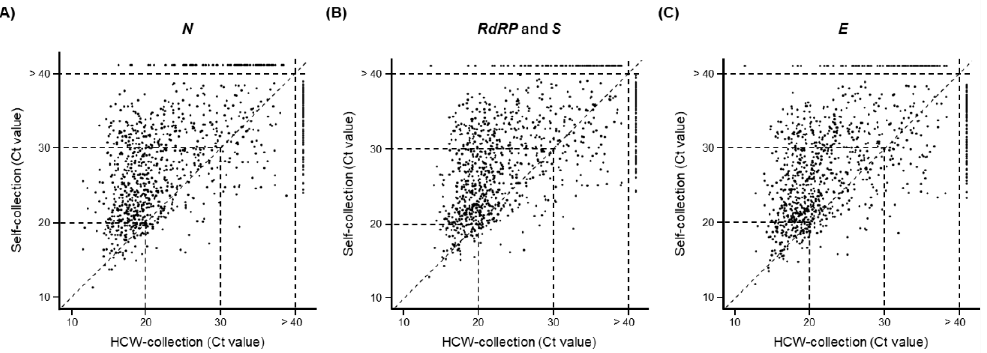
Figure 1. Comparison of Ct values for three SARS-CoV-2 genes detected in 1039 self- and HCW- collected samples that were positive for SARS-CoV-2. ( A ) N , ( B ) RdRP and S , and ( C ) E . The dotted lines between the x- and y-axis of the scatterplot indicate the reference Ct values of 20, 30, or 40. Each sample was tested using real-time PCR under the indicated conditions.